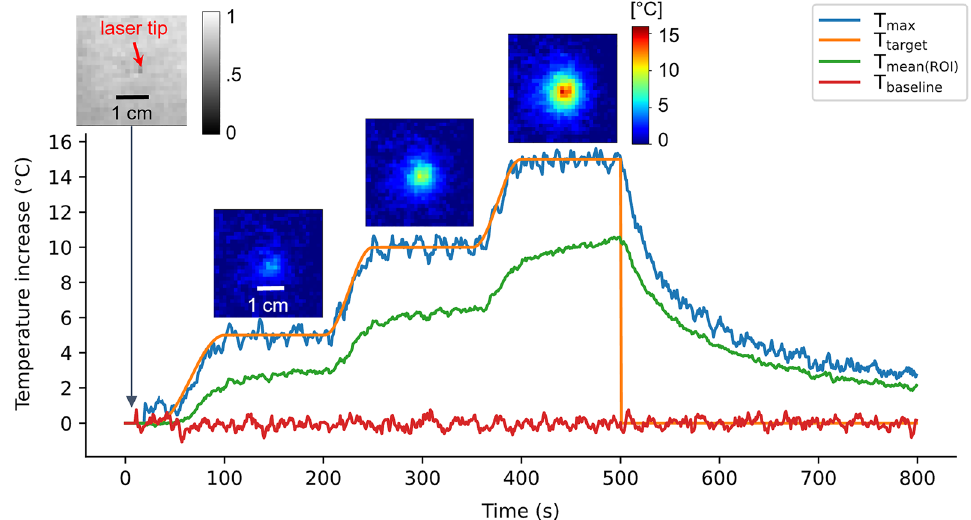
Figure 3. Example of an automatic temperature regulation during LITT in a gelatin gel, for a temperature–time profile showing 3 successive plateaus (5 °C, 10 °C, and 15 °C—100 s duration each). Target temperature profile (orange), maximal (blue), and mean (green) temperature curves over the 3 The red curve shows temperature evolution in a non-heated single voxel. Image insets: magnitude image (W&B left image) of the thermometry sequence and temperature maps obtained in the middle of each temperature plateau (3 colored right images, same color scale).